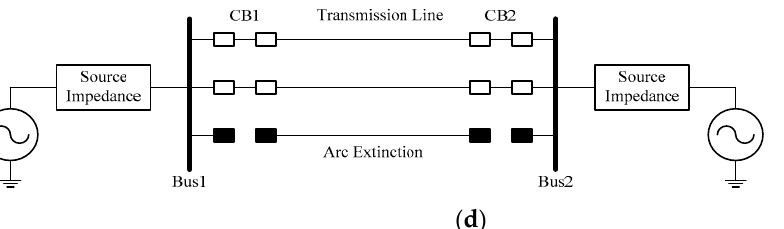
Figure 1. Advanced adaptive single-pole auto-reclosing (ASPAR) operation sequence: ( a ) transmission line under normal operation; ( b ) single-pole to ground fault (transient or permanent); ( c ) isolation of the faulted phase through a conventional scheme; ( d ) extinction of the secondary arc due to a transient fault after an unknown time.